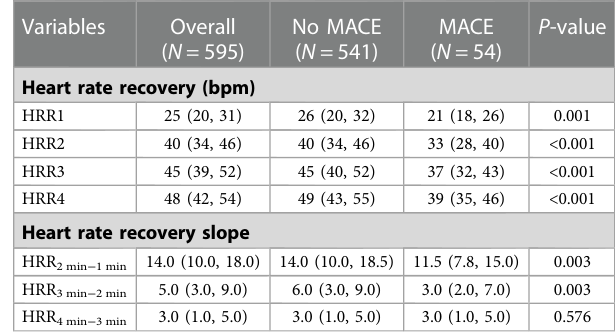
TABLE 2 Heart rate recovery and slope